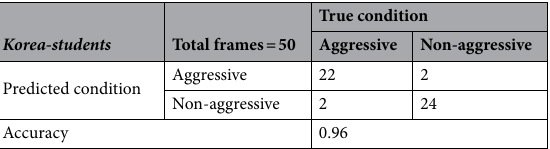
Table 1. Comparison of the predicted results and real conditions of the proposed scheme with the test fragments of Korea-students .